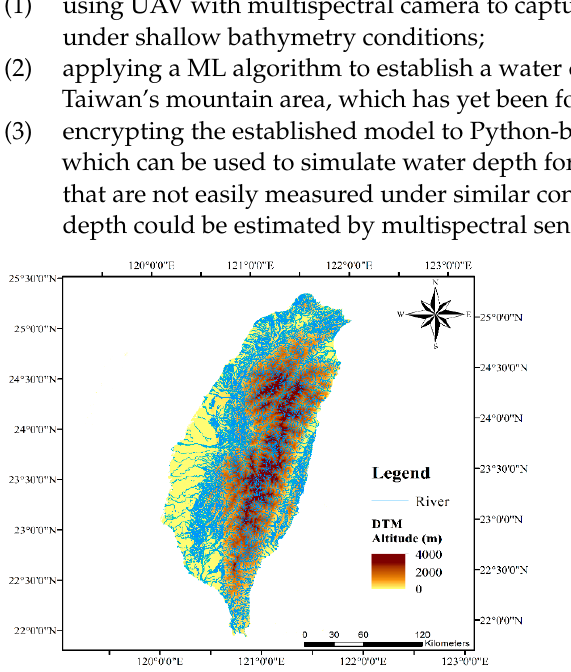
Figure 1. Digital terrain model (DTM) map of the rivers in Taiwan.